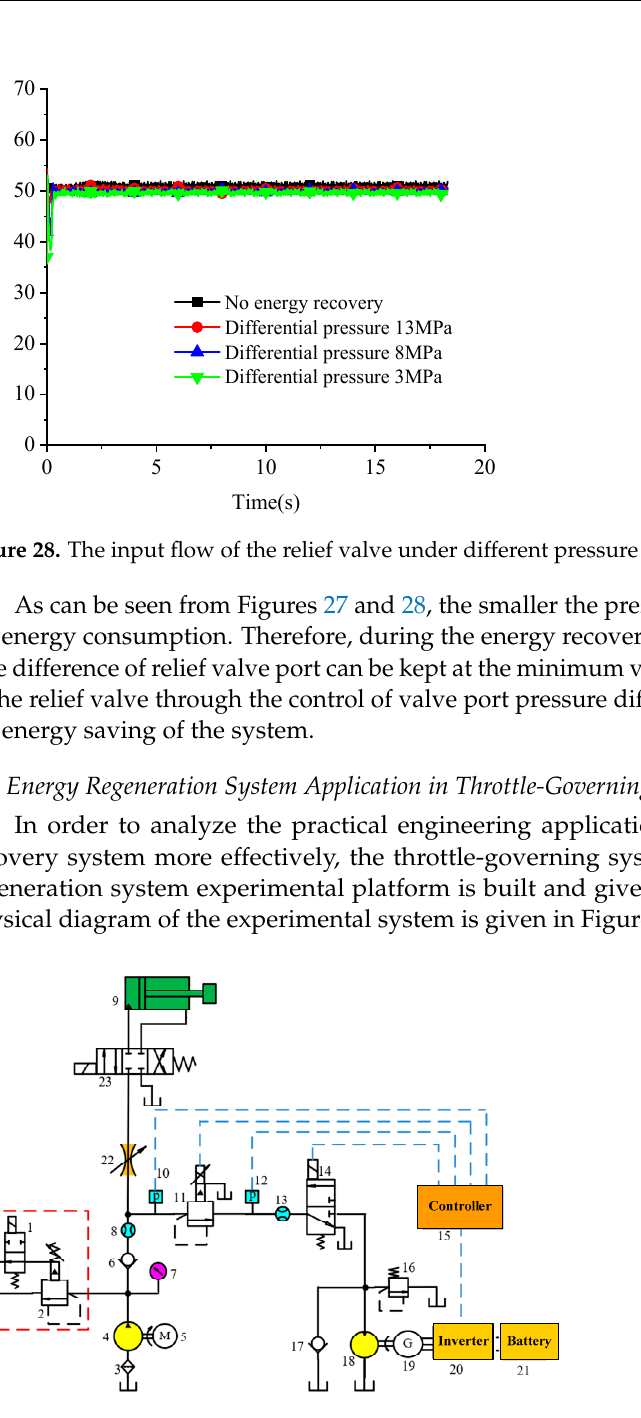
Figure 29. Throttle-governing system with overflow energy regeneration system.